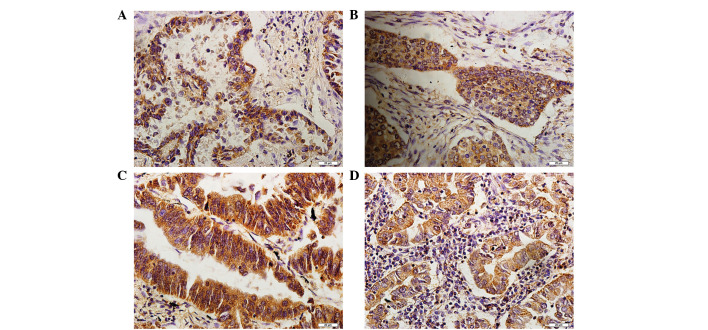
Immunohistochemical results of NEK2 in NSCLC. (A) The expression of NEK2 in moderately differentiated lung ADC. (B) The expression of NEK2 in moderately differentiated lung SCC. (C) The expression of NEK2 in bronchioalveolar carcinoma. (D) The expression of NEK2 in lung adenosquamous carcinoma. (bar, 20 μm). NEK2, never in mitosis gene A (NIMA)-related kinase 2; NSCLC, non-small cell lung cancer; SSC, squamous cell carcinoma; ADC, adenocarcinoma.